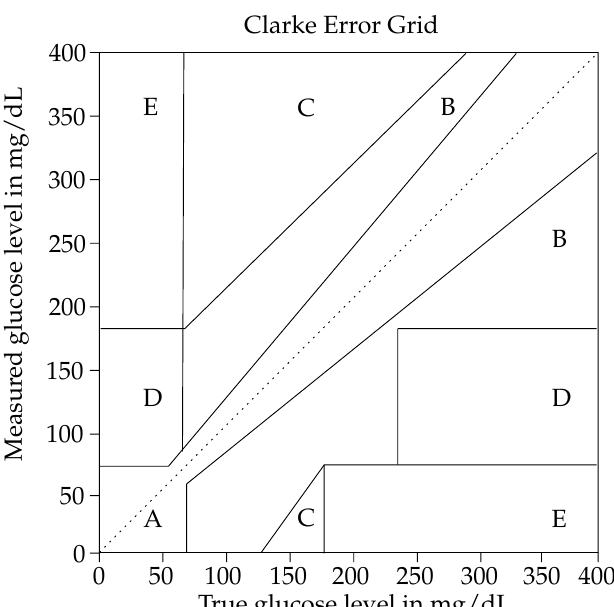
Figure 14. Clarke error grid model. The region A shows the desired accuracy of a glucose sensing system to fulfill clinical accuracy